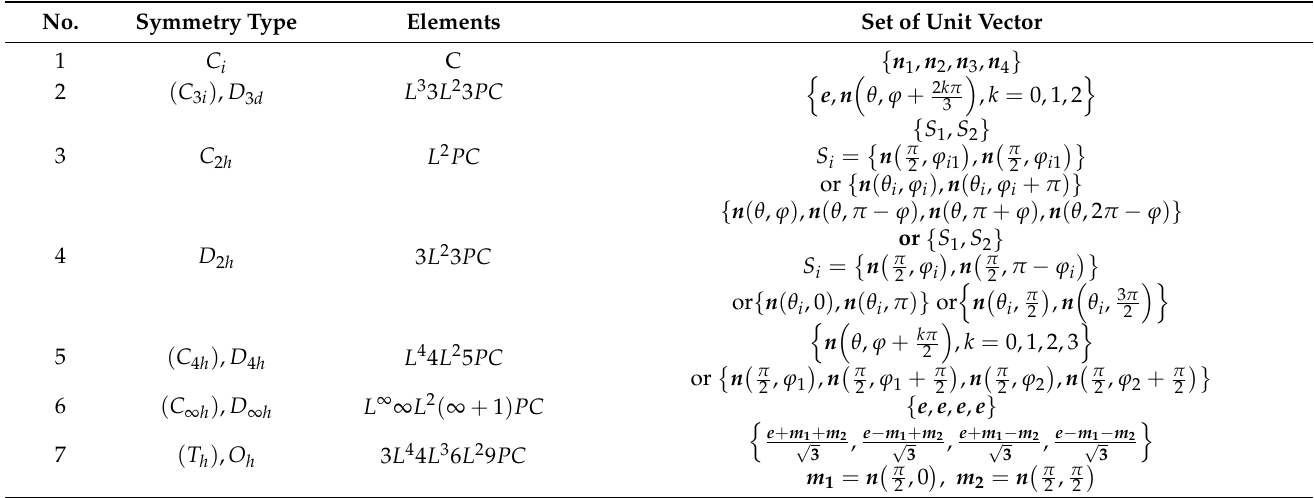
Table 4. Symmetry types and the unit vector sets of H ( 4 )